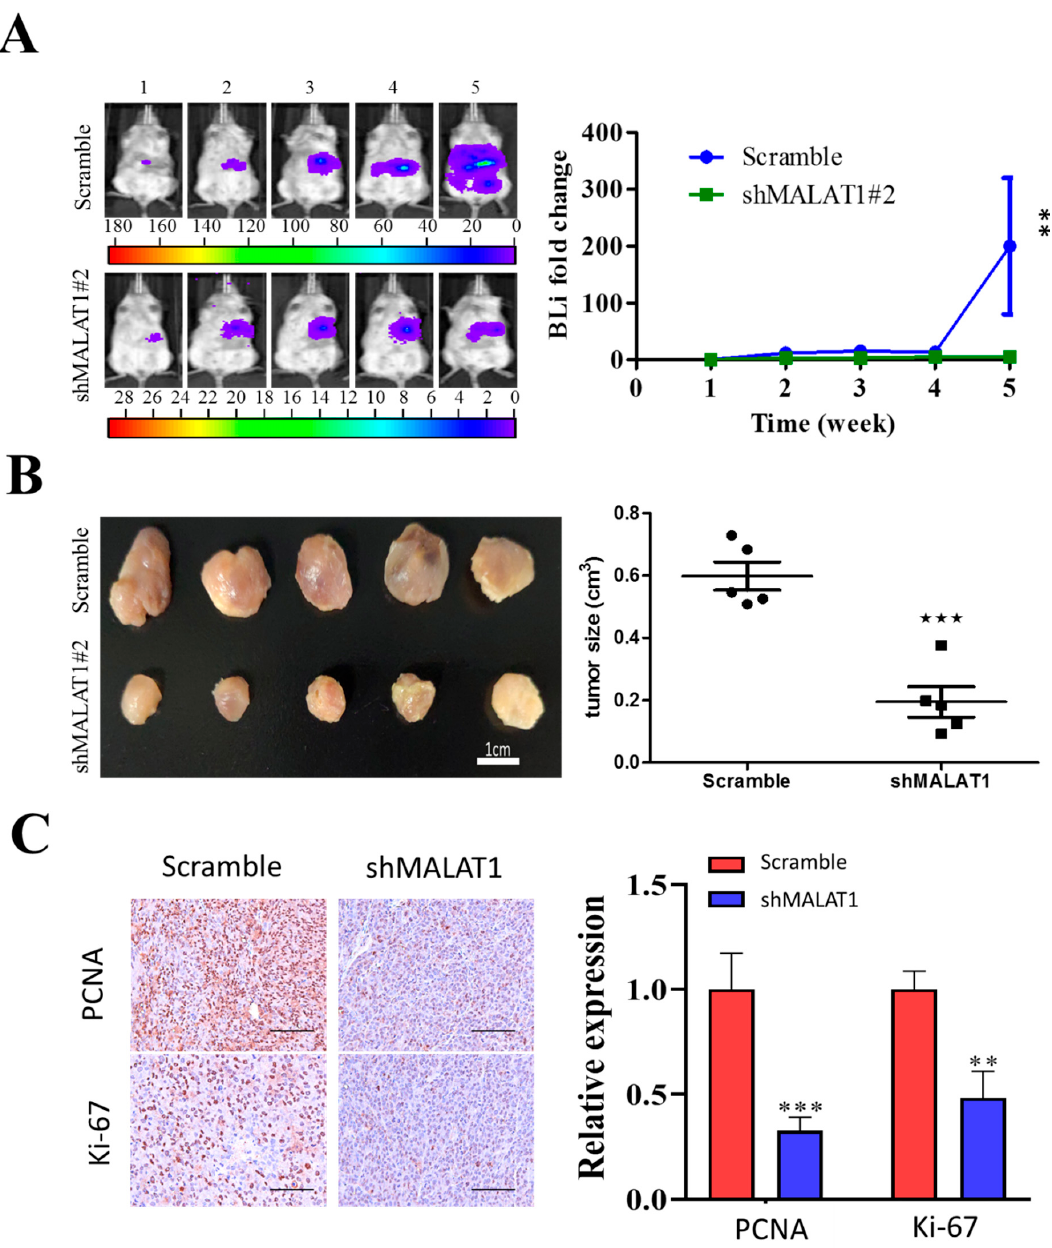
Figure 6. MALAT1 depletion impedes xenograft growth of HCC cells. Luciferase-expressing SK-Hep1 cells with or without MALAT1 depletion were injected into NOD / SCID mice. ( A ) Representative images comparing the tumorigenic potential in NOD / SCID mice bearing scrambled control or shMALAT1#2 SK-Hep1 tumors over a period of 5 weeks using bioluminescence imaging technique. Semi-quantitative analysis of the change in bioluminescent intensity (fold change) over time curve showed a significantly lower tumor burden was in the shMALAT1 group. ( B ) Photographs of the tumor samples harvested, and tumor volumes measured at week 5, demonstrating the shMALAT1 tumors were significantly smaller than the control counterparts. ( C ) Representative histochemical staining of Ki-67 and PCNA in primary HCC tumor cells from control and MALAT1 shRNA-transfected mice. The percentage of tumor cells that were positive for Ki-67 and PCNA was calculated by counting 10 visual fields at high magnification. Scale bars, 50 µ m. Bioluminescence intensity, BLI; PCNA, proliferating cell nuclear antigen. Data are mean ± SEM **, p < 0.01; ***, p < 0.001.